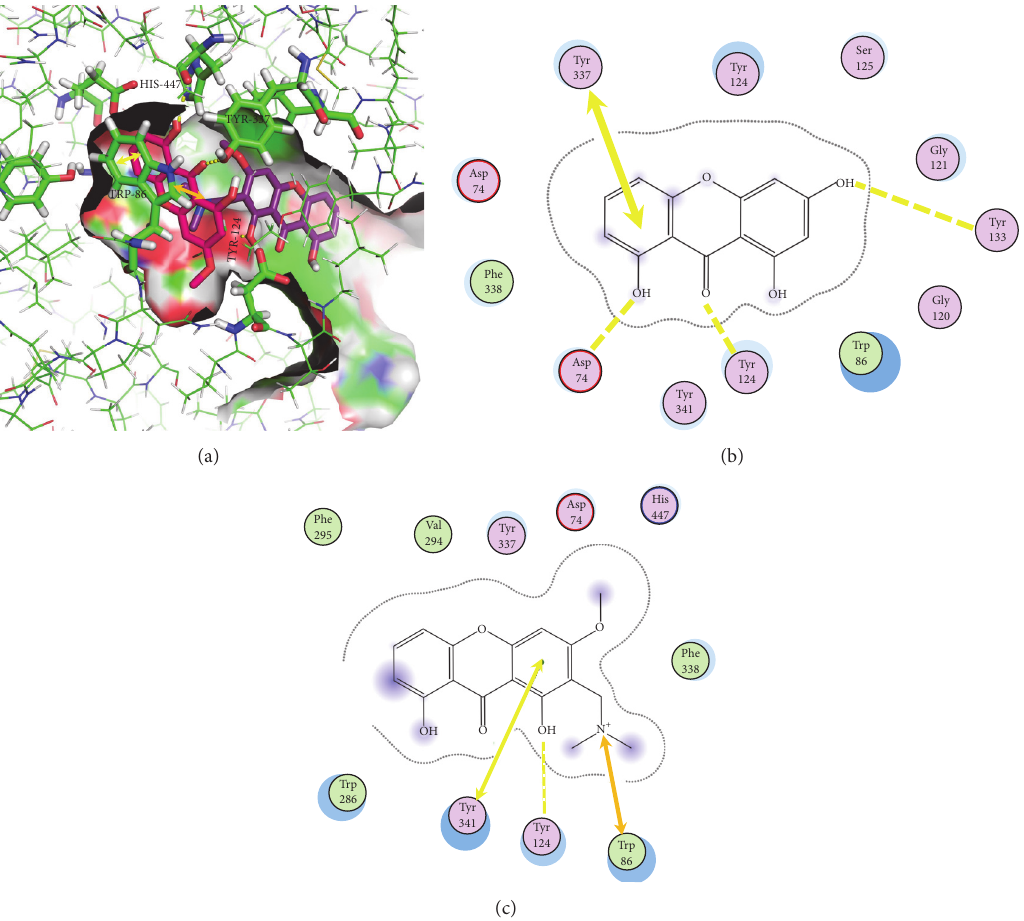
Figure 4: AChE active site (surface) bound to 2 (pink sticks) and 3 (purple sticks) (pdb ID: 4EY7) (a); residues involved in hydrogen interactions(yellowbrokenline), 𝜋 stackinginteractions(yellowdoublearrow),and 𝜋 -cationinteractions(orangedoublearrow)aredisplayed using a stick model. AChE carbon, oxygen, nitrogen, and hydrogen are represented in green, red, blue, and grey, respectively. 2D depiction view of 2 (b) and 3 (c) docked into AChE active site. Hydrogen, 𝜋 stacking, and 𝜋 -cation are represented with the same color scheme. Receptor residues that are close to the ligand, but whose interactions with the ligand are weak or diffuse, such as collective hydrophobic or electrostatic interactions, are also represented (all the ones that have no indication for hydrogen-bonding). Solvent accessible surface area of the ligand is plotted directly onto the atoms in the form of a blue smudge. Solvent accessible surface area for the receptor residues is plotted as a blue